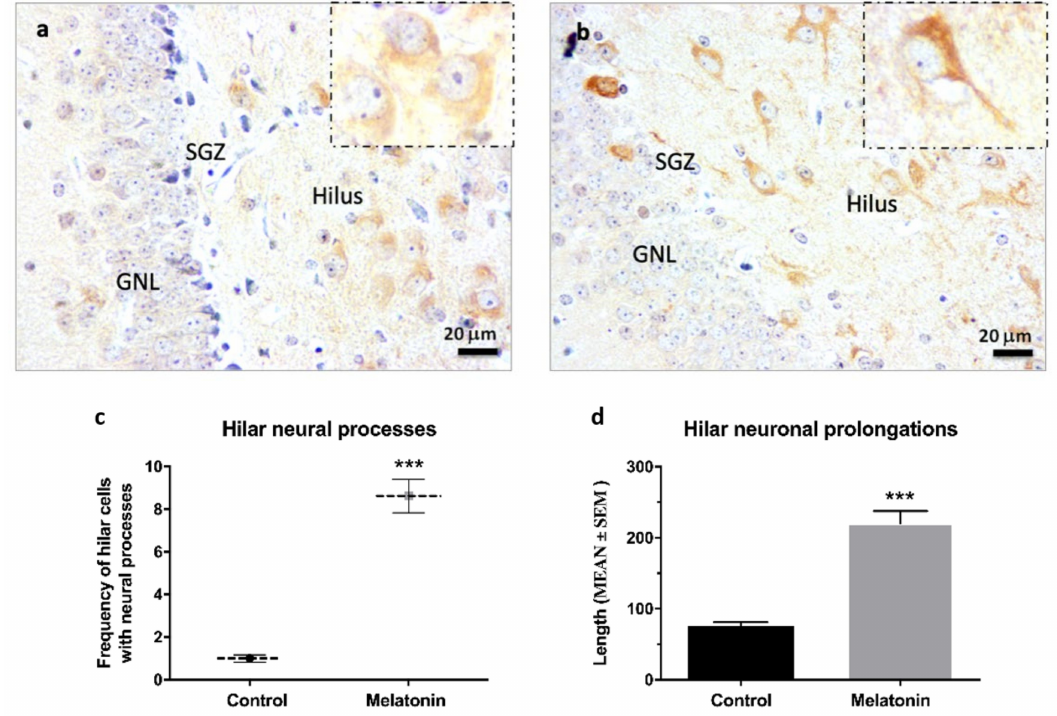
Figure 5. β -Tubulin III immunostaining in the hippocampal dentate gyrus of SAMP8 mice at 400 × magnifications. The small box shows details of hilar neurons in control mice ( a ) and melatonin- treated mice ( b ) at 1000 × magnifications. GNL, the granule neurons layer; SGZ, the subgranular zone. ( c ) Frequency of hilar cells positive for β -Tubulin III with evident neural processes were calculated at 400 × magnifications ( d ) Length of neural prolongations in hilar cells positive for β -Tubulin III were measured at 400 × magnifications. Data are expressed as means ± SEM. *** p < 0.001 vs. control. Statistical analysis was always performed in 10 images obtained from each SAMP8 control mice ( n = 4) and SAMP8 mice treated with melatonin ( n =